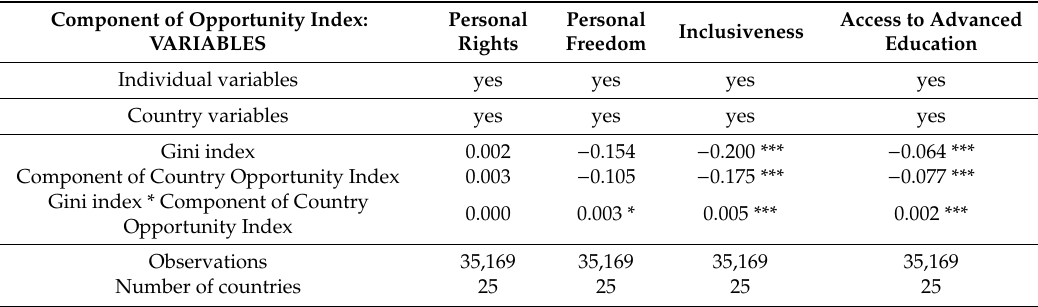
Table 2. Determinants of life satisfaction, components of Opportunity